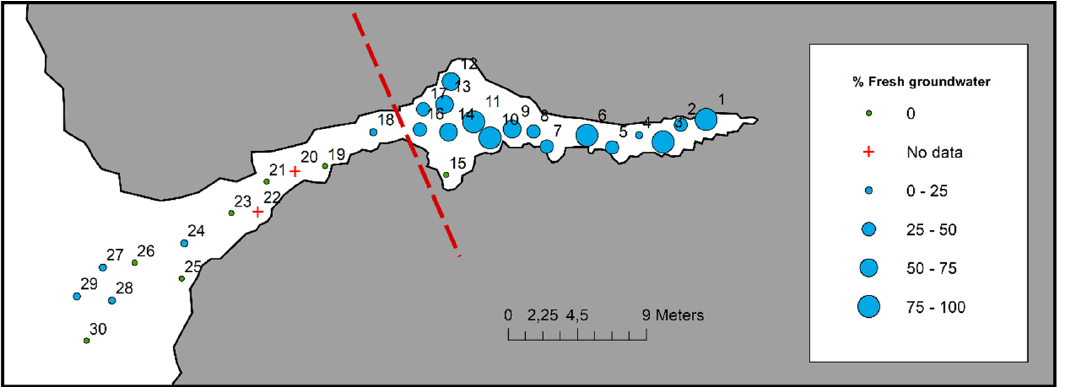
Figure 7. The mean percentage of fresh groundwater calculated from the seepage meters experiment. The red dashed line indicates the approximate location of the brackish lagoon water–fresh groundwater interface.